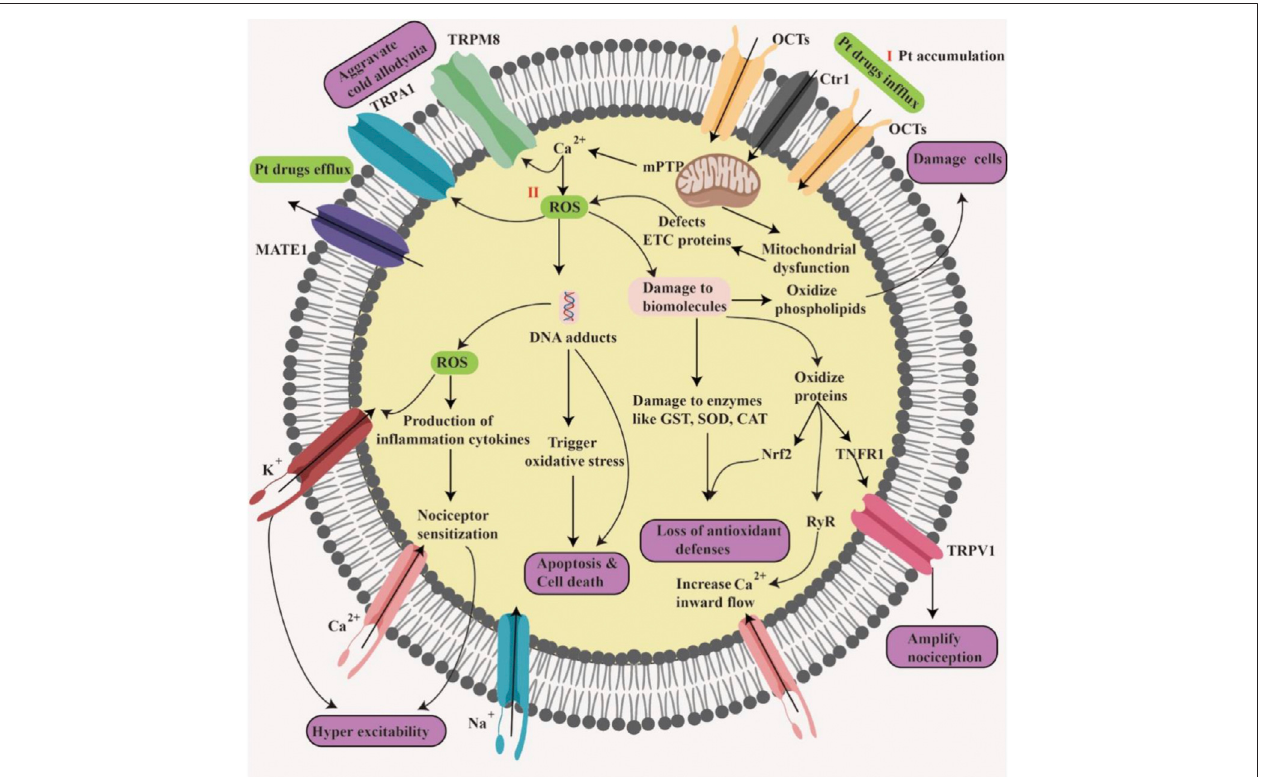
FIGURE 1 | Reactive oxygen species (ROS)-related mechanism of platinum-induced peripheral neuropathy (PIPN). I. Pt drug accumulation is mediated by the uptakeviaOCTsandCtr1,andef fl uxviamultidrugandtoxinextrusionprotein1(MATE1).II.Ptdrugscausemitochondrialdysfunctionandoxidativestress,leadingtothe imbalance in the endogenous ROS and cellular antioxidant systems. Moreover, Pt-induced ROS result in the damage to biomolecules, such as phospholipids and proteins[e.g.,ryanodinereceptor(RyR),NF-E2-relatedfactor2(Nrf2),andtumornecrosisfactorreceptor1(TNFR1)],downregulationofantioxidantenzymes[e.g., SOD, CAT,and glutathione-S-transferase (GST)], the activation oftransientreceptor potentials (TRP),the oxidization ofionchannels (e.g.,K + ,Ca 2+ ,and Na + ),aswellas the release of in fl ammatory cytokines, ultimately aggravating the progress of